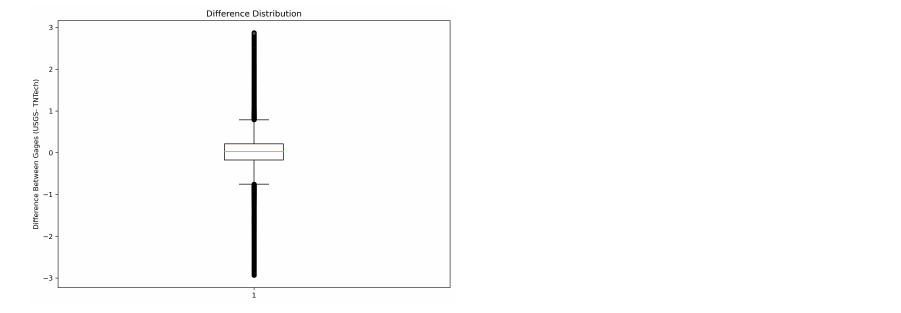
Figure 7. Box plot comparison of the differences between TNTech and USGS water levels